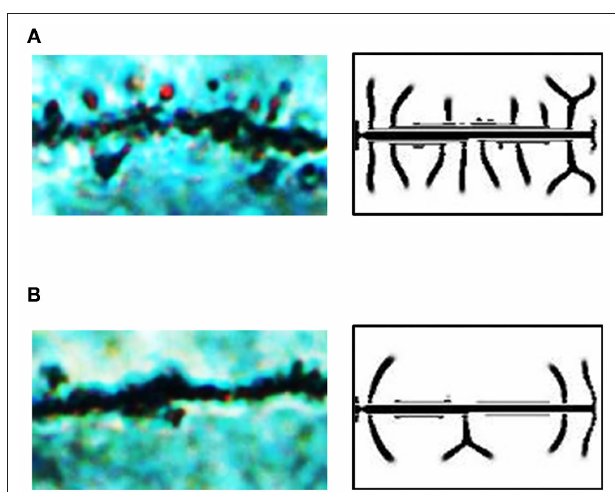
FIGURE 6 | Exogenous inhibitor decreases the spine density in hippocampal CA1 in SD rats with glioma. (A) A microscopic image of dendritic spines in the brain of a rat in the sham group. There are dense spines in this image, similar to those in our dendrite simulation results under the condition of δ A = 0.01, δ H = 0, ε = 1. (B) A microscopic image of dendritic spines in the brain of a rat in the glioma group. There are sparse spines in this image, similar to those in our dendrite simulation results under the condition of δ A = 0.01, δ H = 0.0001, ε = 1. In (A,B) , fixed parameters in Equation (2): c = 0.002, µ = 0.16, υ = 0.04, ρ A = 0.02, ρ H = 0.00005, c 0 = 0.05, γ = 0.02, D A = 0.02, D H = 0.26, D S = 0.06, d = 0.0035, e = 0.1, and f =